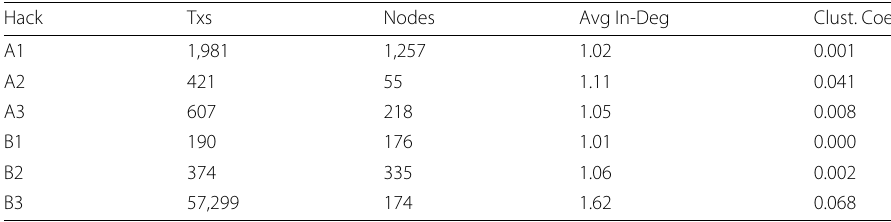
Table 1 Summary Statistics for Each